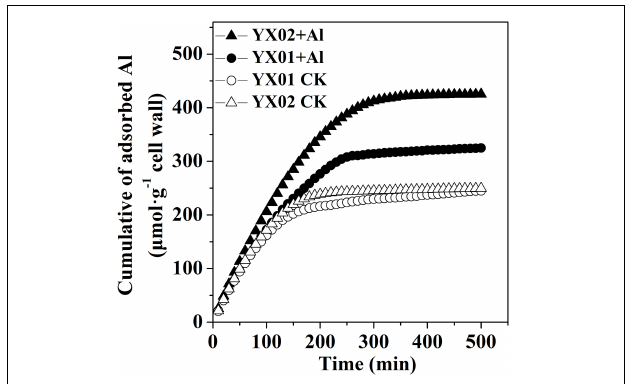
FIGURE 7 | Al adsorption kinetic of cell wall from Chinese fir roots. Two-month-old Chinese fir seedlings were exposed to 1/2 strength complete nutrition solution without Al (CK), or with 1 mM AlCl 3 (Al) for 16 d. After treatment, root tips of Chinese fir were collected for cell wall extraction and